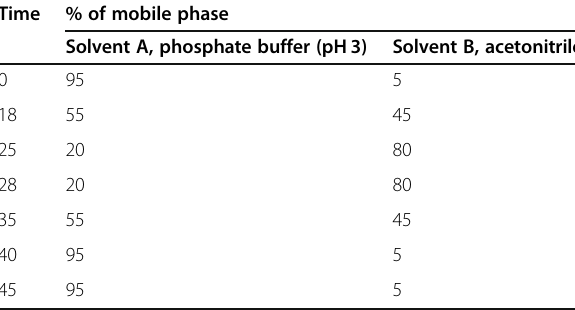
Table 2 Gradient program of optimized mobile